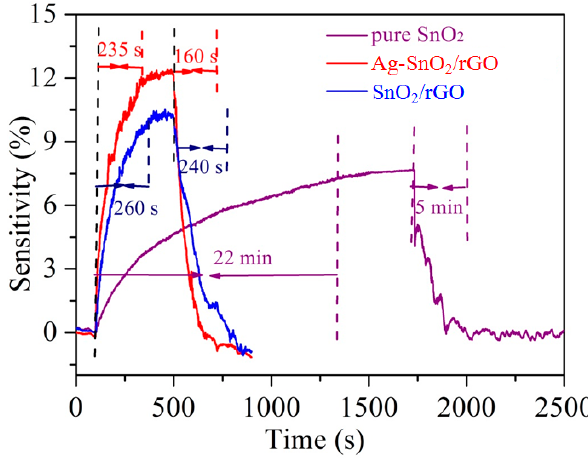
Figure 5. The sensitivity of pure SnO 2 , SnO 2 /rGO and Ag–SnO 2 /rGO film sensors to 50 ppm acetylene at 90 °C.